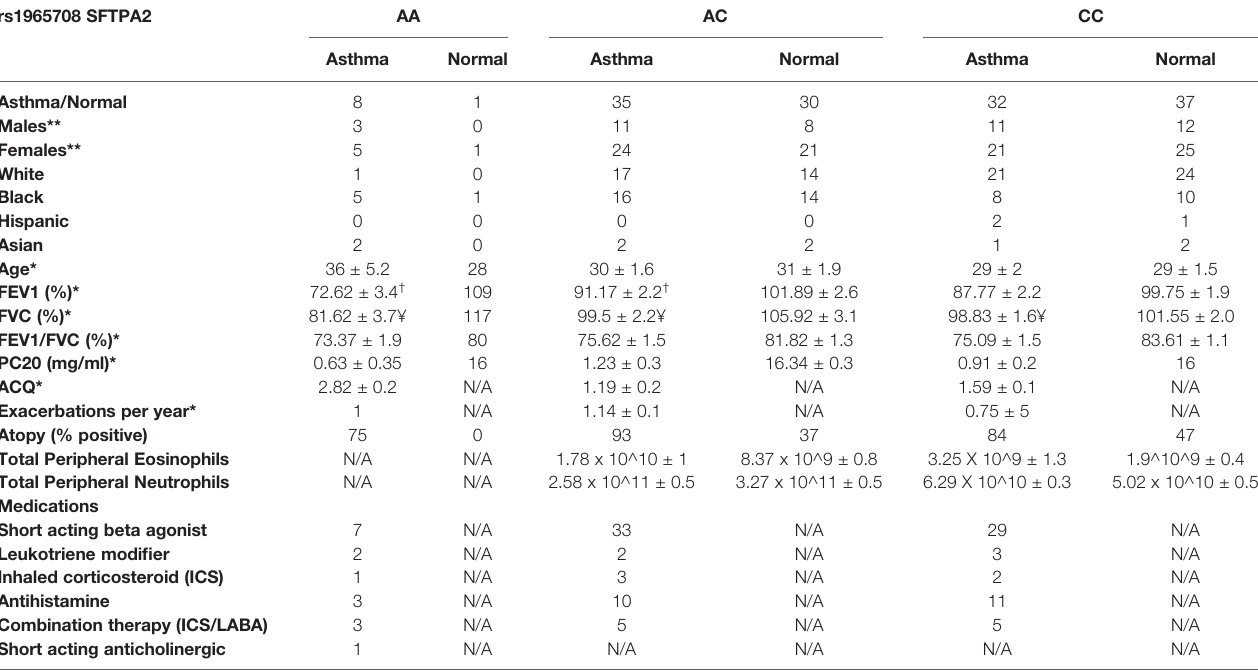
TABLE 1 | Demographics for patients undergoing asthma phenotyping and blood genotyping for SP-A2. rs1965708 SFTPA2 AA AC CC Asthma Normal Asthma Normal Asthma Normal